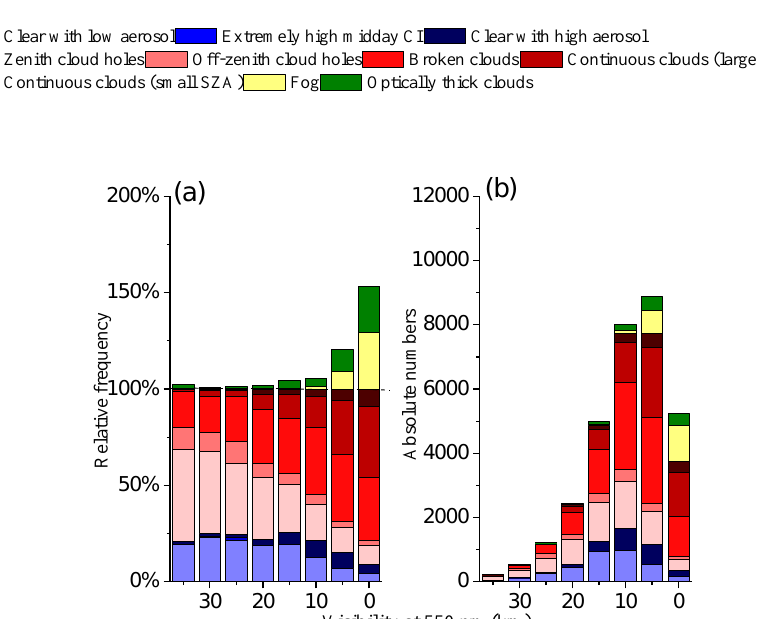
Figure 14. Results of the cloud classification scheme as a function of the visibility at 550nm obtained from the visibility meter. (a) Relative frequencies of the different sky conditions (see the caption of Fig. 10). (b) Absolute numbers of the sky conditions as a function of the visibility.